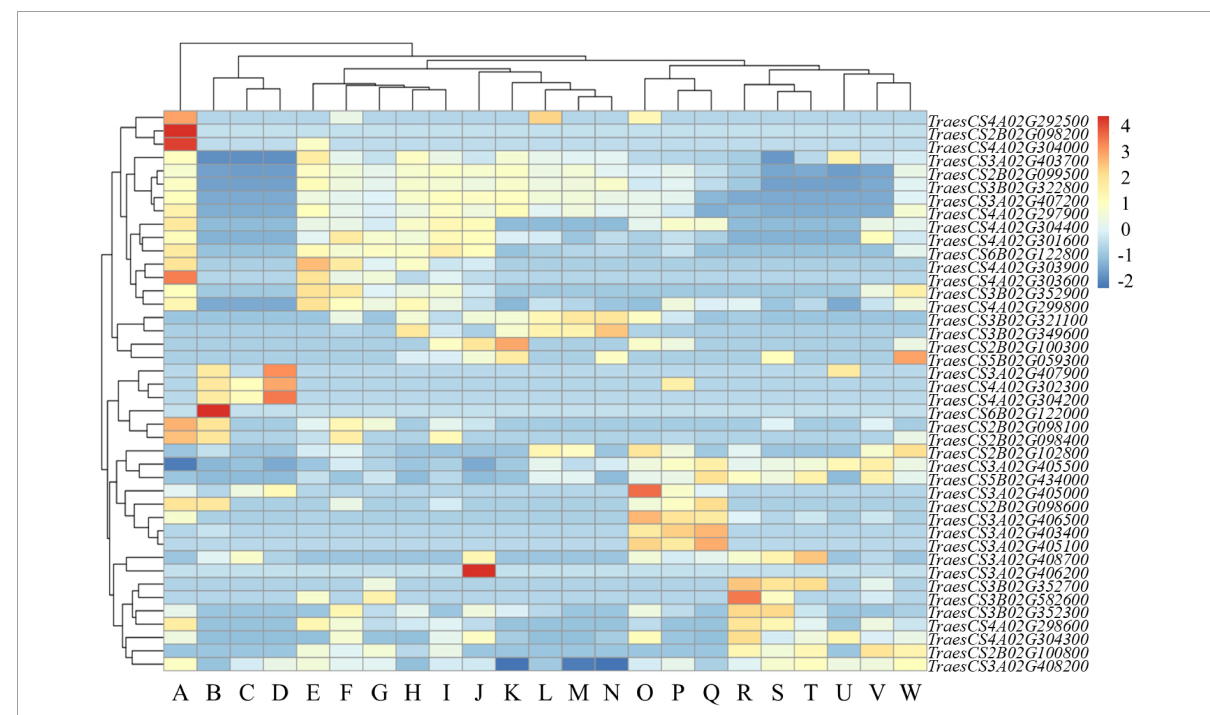
FIGURE4 Expression profile of functional interval genes. Based on the Z -score of the TPM plotting Heatmap, – 2 to 4 represent expression levels from low to high. (A: coleoptile; B: grain; C: endosperm; D: aleurone layer; E: stem axis; F: first leaf sheath; G: seedling; H: first leaf blade; I: shoots; J: leaf; K: flag leaf; L: glumes; M: awns; N: flag leaf blade; O: lemma and rachis; P: spikelets; Q: stigma or ovary; R: radicle; S: roots; T: root apical meristem; U: embryo; V: shoot apical meristem; W: